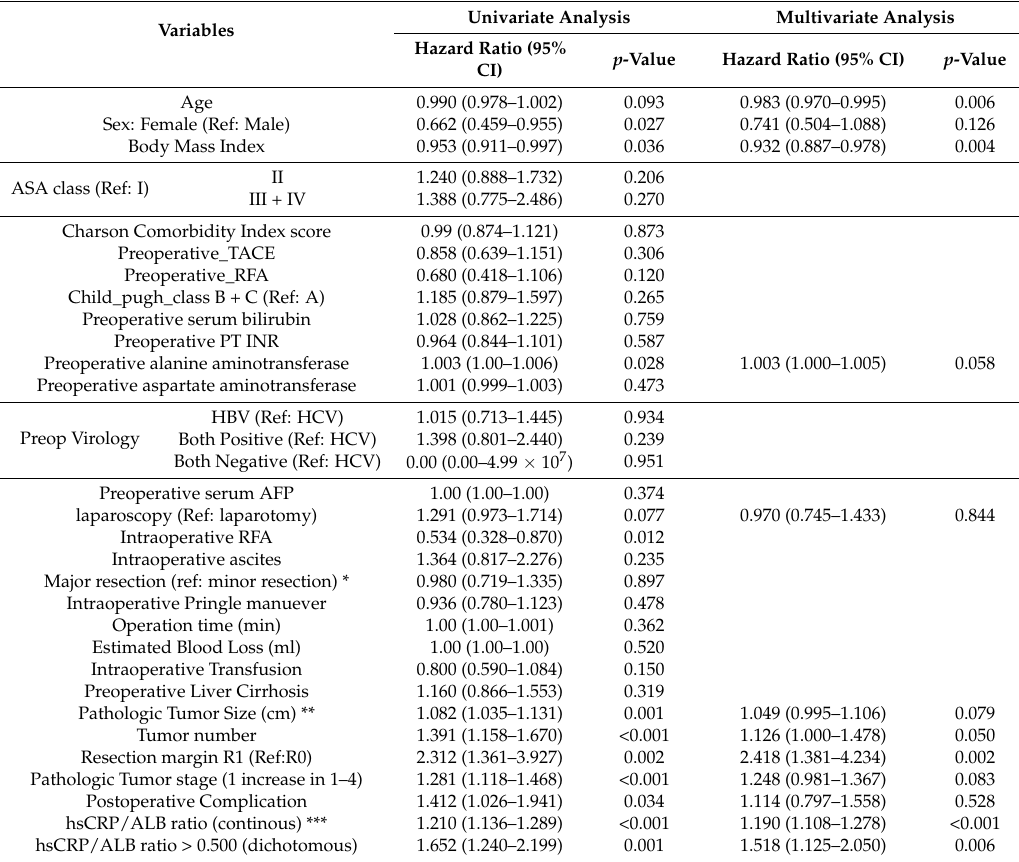
Table 3. Multivariate Cox regression analysis for recurrence after HCC